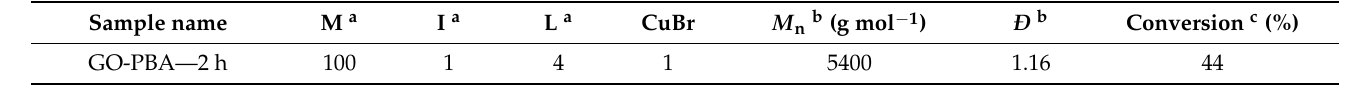
Table 2. Reaction conditions for the performed grafting of PBA from the GO